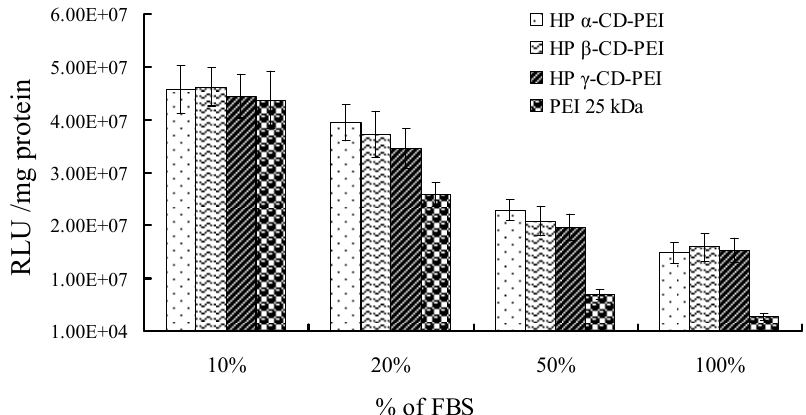
Figure 6. Transfection efficiency of polymer/DNA complexes (at N/P ratio of 50) in different FBS concentrations medium in SK-BR-3